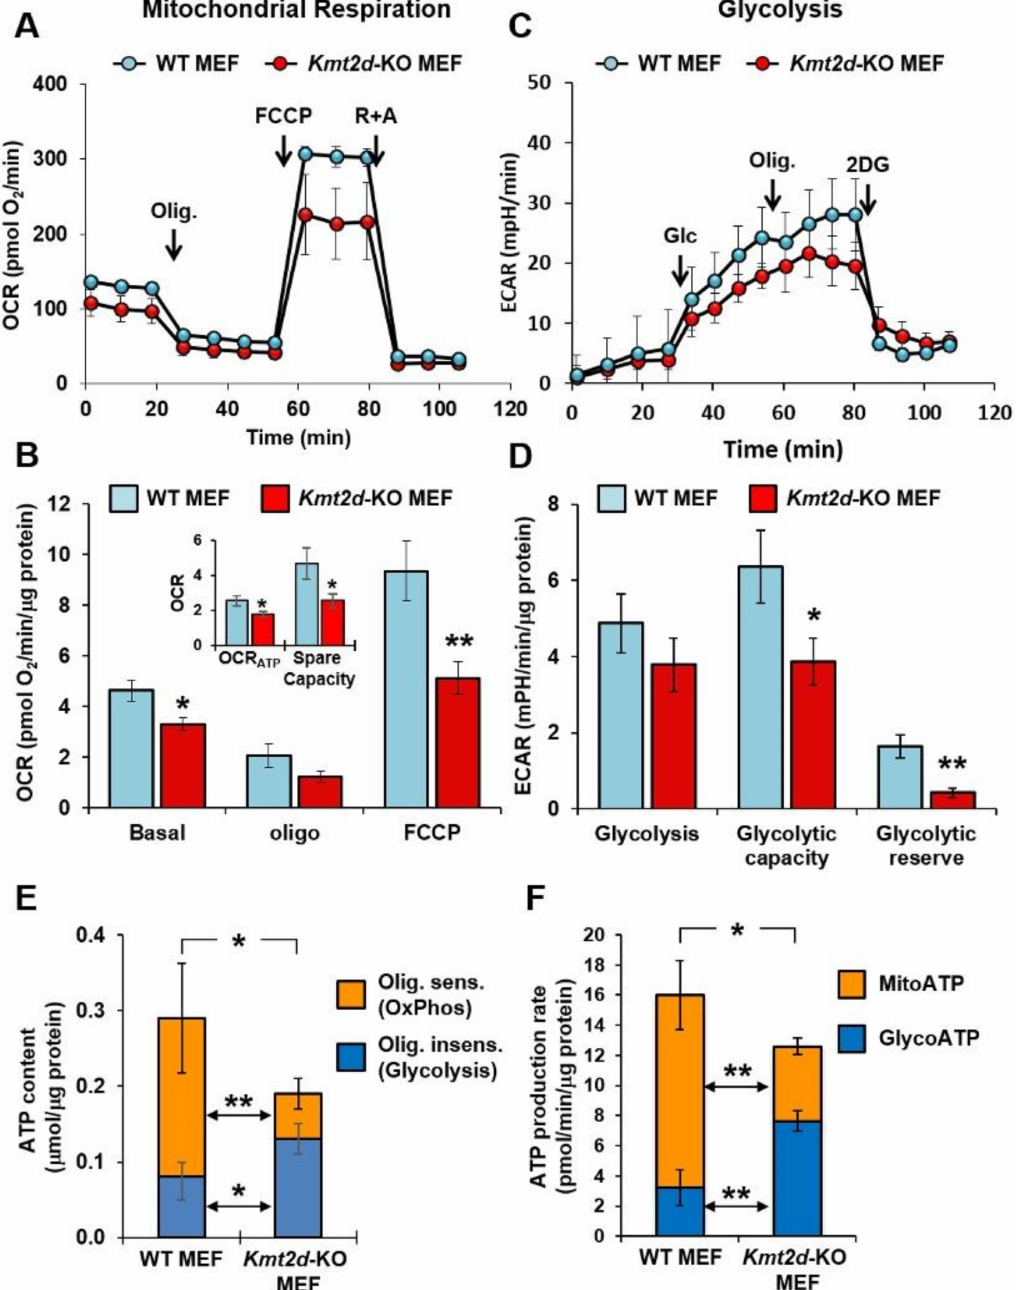
Figure 1. Metabolic fluxes analysis of WT and Kmt2d-KO MEF. Cells were analyzed in microplates by Seahorse XP 96 according to the Mito Stress protocol of the manufacturer. ( A ) and ( C ) are representative traces of the oxygen consumption rates (OCRs) and extracellular acidification rates (ECARs), respectively. Where indicated, the following compounds were injected into the assay micro-chambers: oligomycin (Olig.), carbonyl cyanide-4-(trifluoromethoxy)phenylhydrazone (FCCP), rotenone plus antimycin